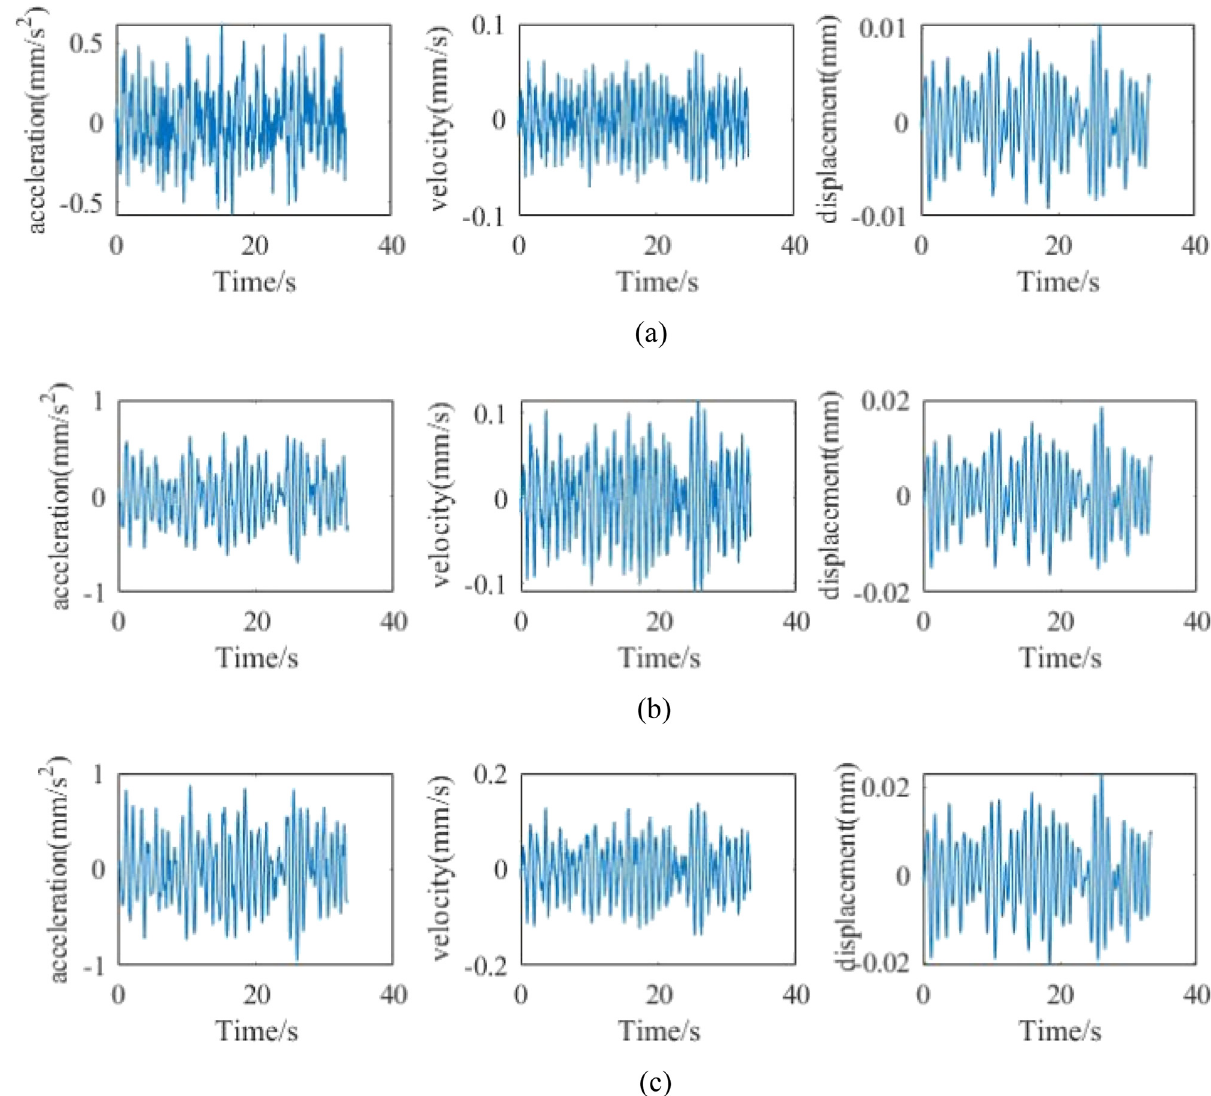
Figure 7: Response of three - layer frame structure: ( a ) response of the fi rst layer structure, ( b ) response of the second layer structure, and ( c ) response of the third layer